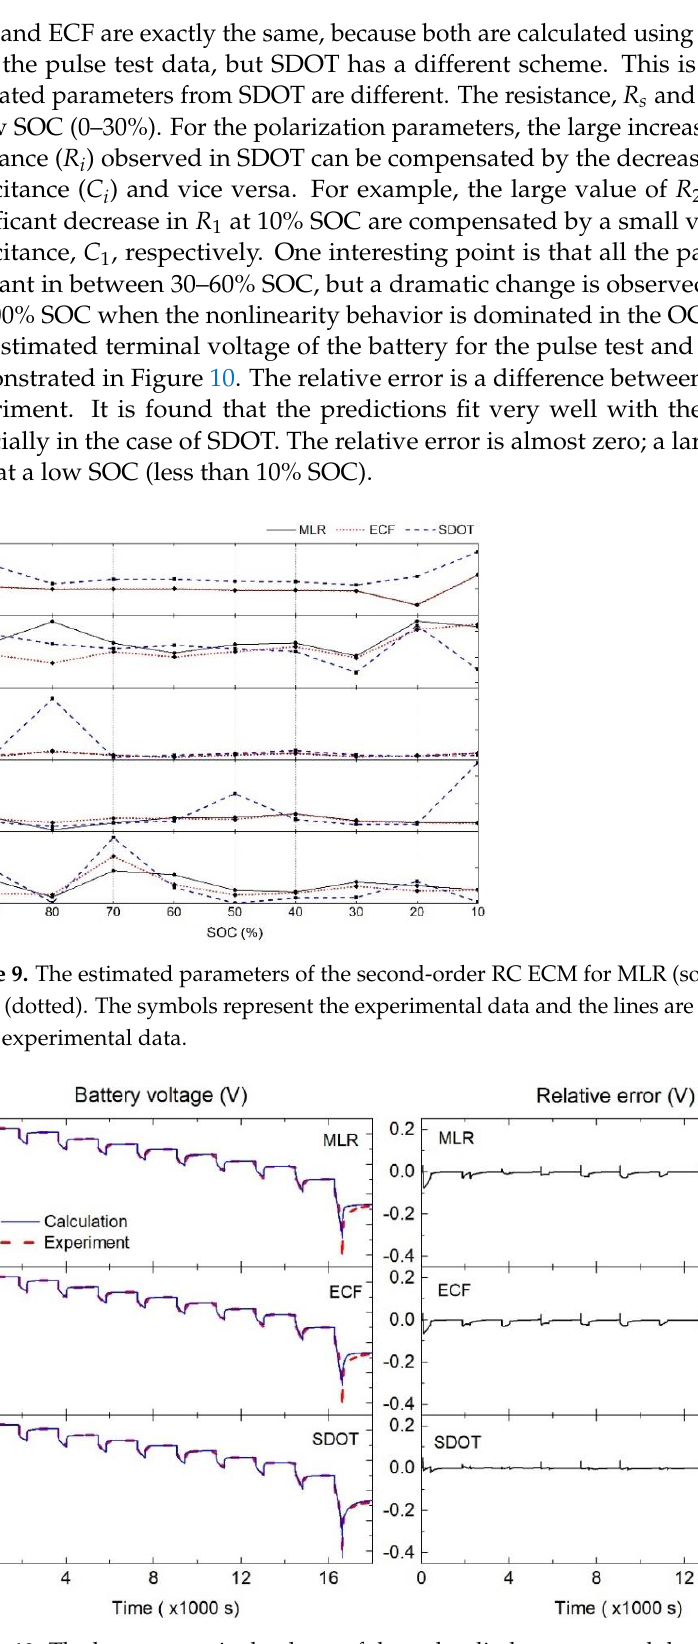
8 of 13 Figure 8. Dynamic test profiles for ( a ) ISO12405-2 : 2012 (profile B) [36] and ( b ) WLTP (class 3) [37]. The numbers 1 and 2 on the right-hand side in ( a ) represent the discharge and charge processes,